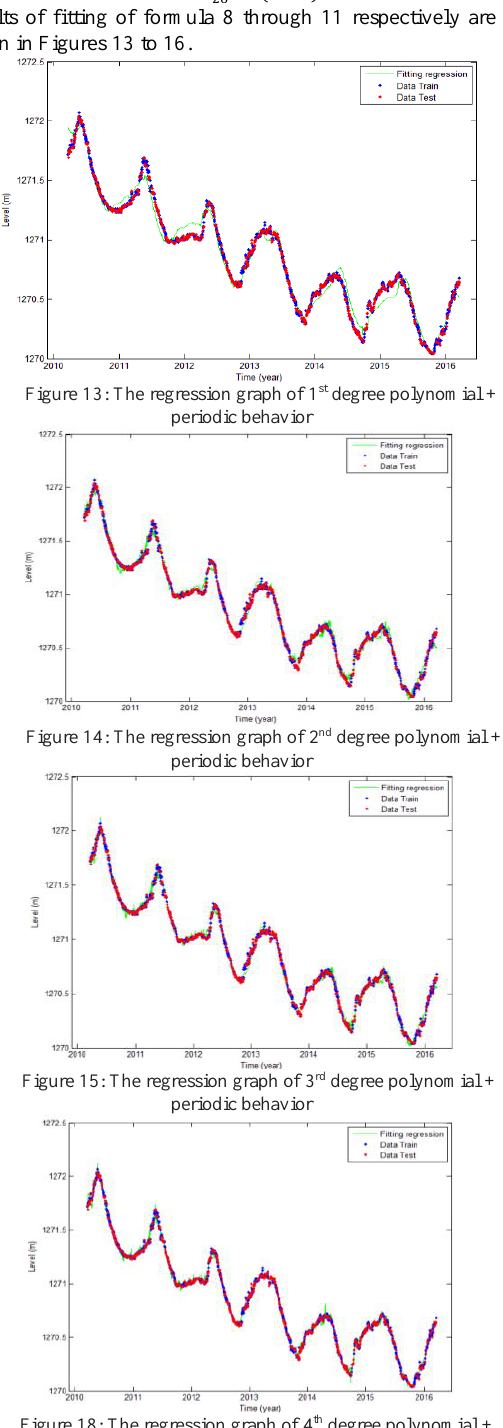
Figure 18: The regression graph of 4 th degree polynomial + periodic